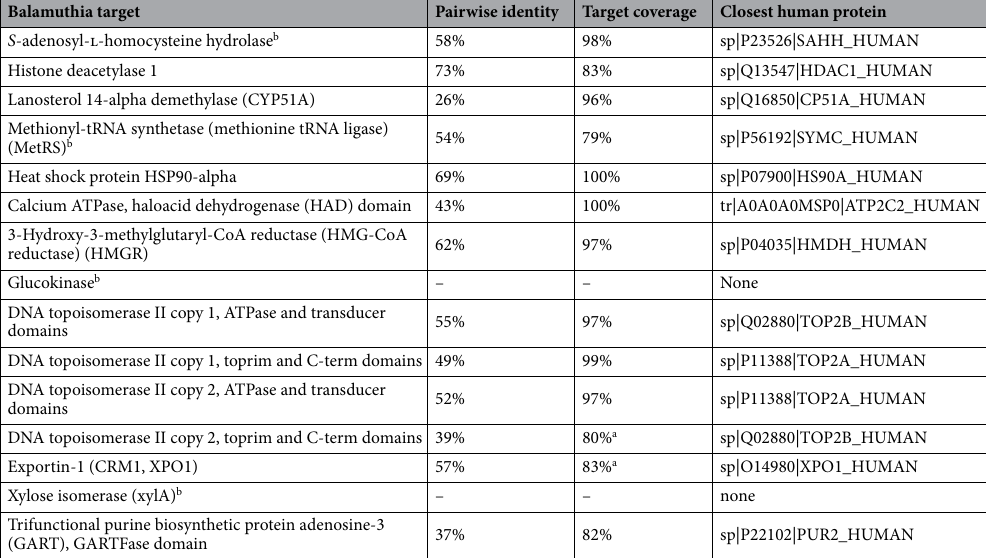
Table 3. Sequence similarity (BLASTP) between Balamuthia validated sequences and UniProt identifiers of closest human counterpart. a Lower than expected coverage due to incomplete sequencing of the clones. b Additional targets selected by the community. Note that homology to human Glucokinase was too low to be detected with BLASTP at the chosen E-value (1e−3).